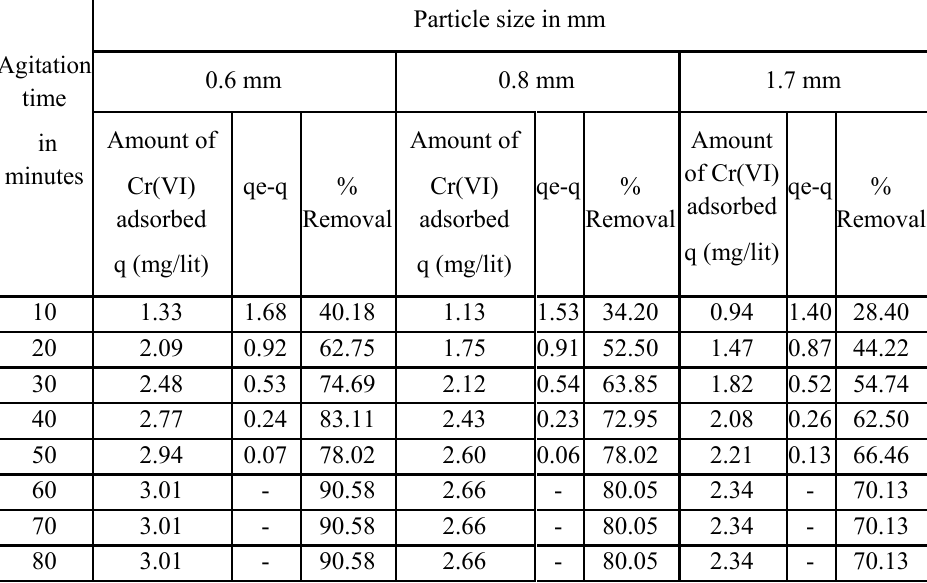
Table 5. Adsorption of chromium (VI) on different particle sizes (mm) of the adsorbent.